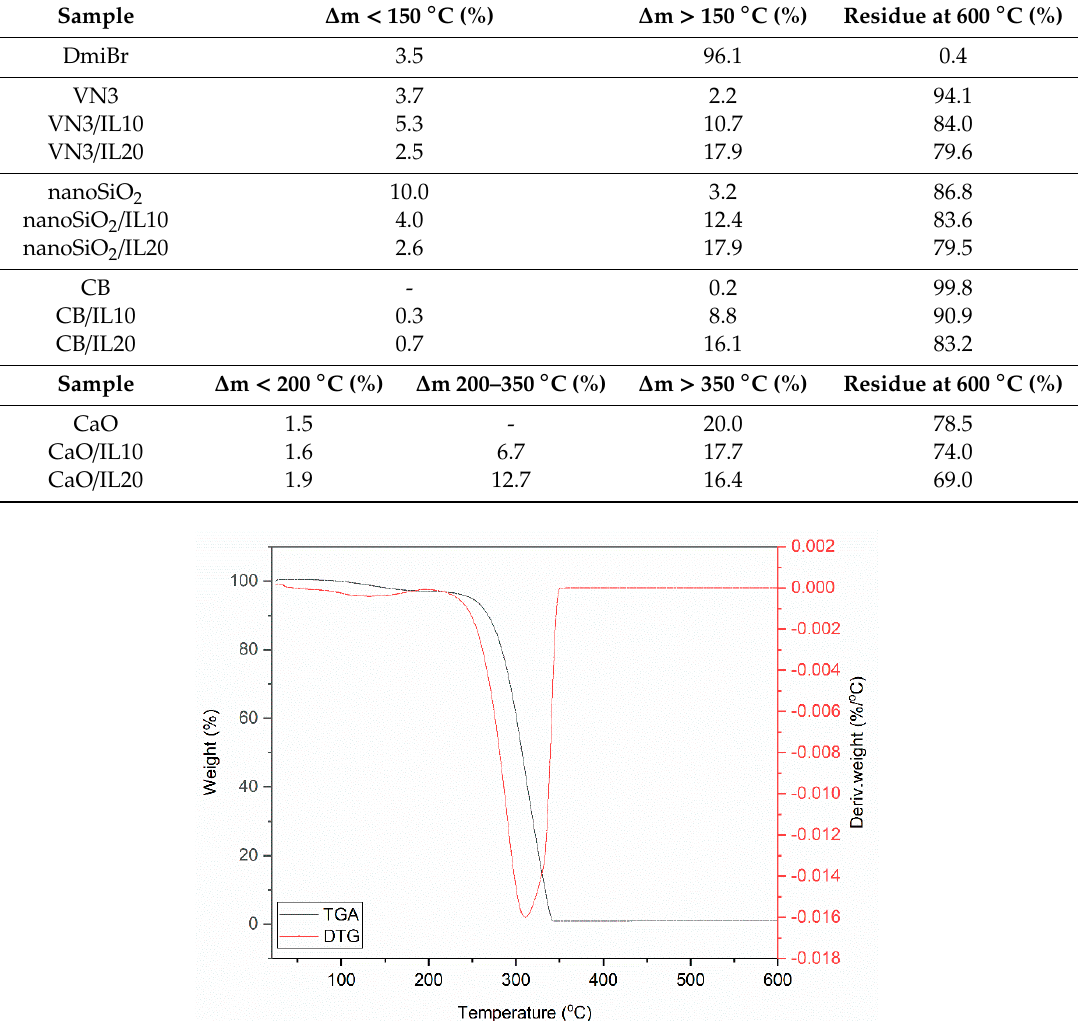
Table 1. Weight losses ( ∆ m) obtained from thermogravimetric (TG) curves for pure and DmiBr-modified fillers.